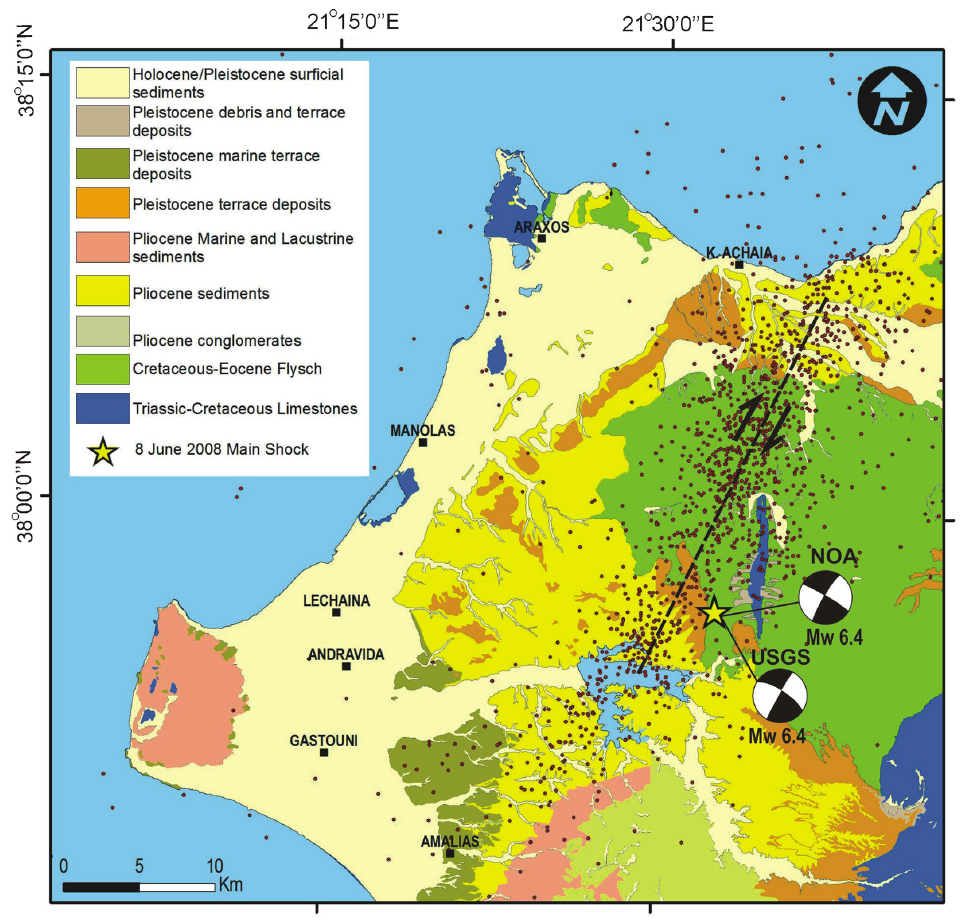
Figure 1. Simplified geological map of the study area showing the location of the seismogenic fault as it was defined by the focal mecha- nisms and the alignment of aftershocks from June 8 to 16,